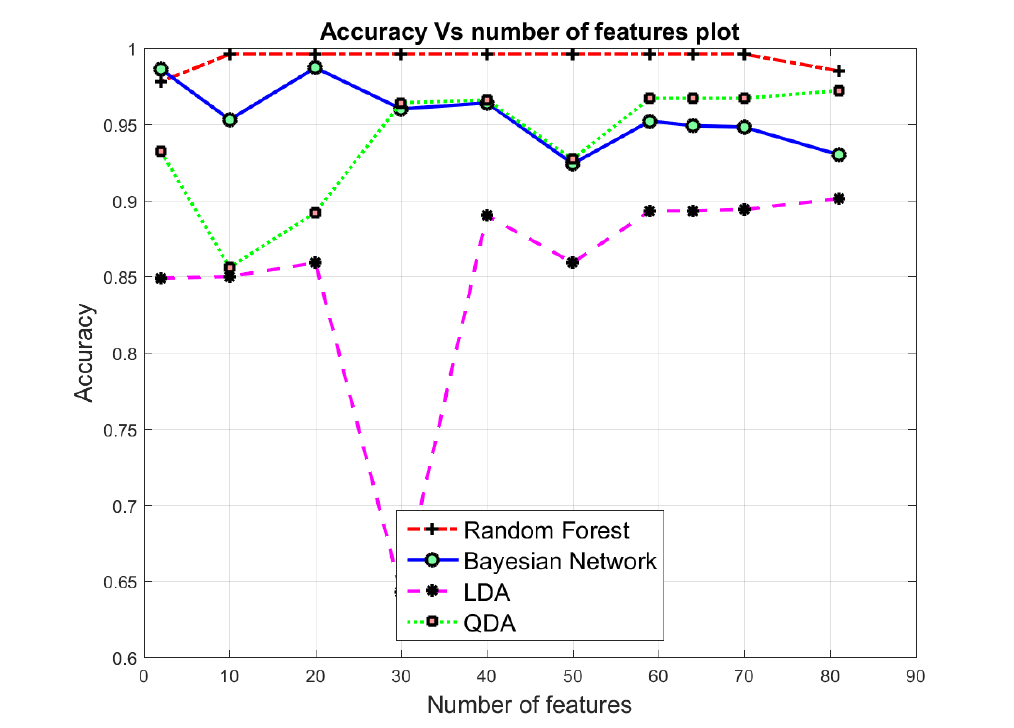
Figure 5. Multi Class Classification: Accuracy in terms of number of components using PCA.